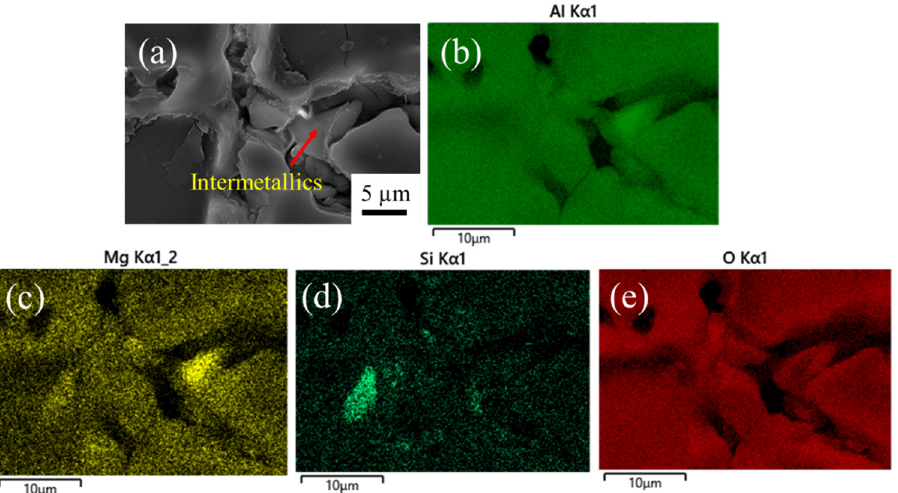
Figure 5. EDS element mapping of the oxide film surface in the sample etched for 2 min: ( a ) SEM image, and EDS mapping elements: ( b ) Al, ( c ) Mg, ( d ) Si, and ( e) O.